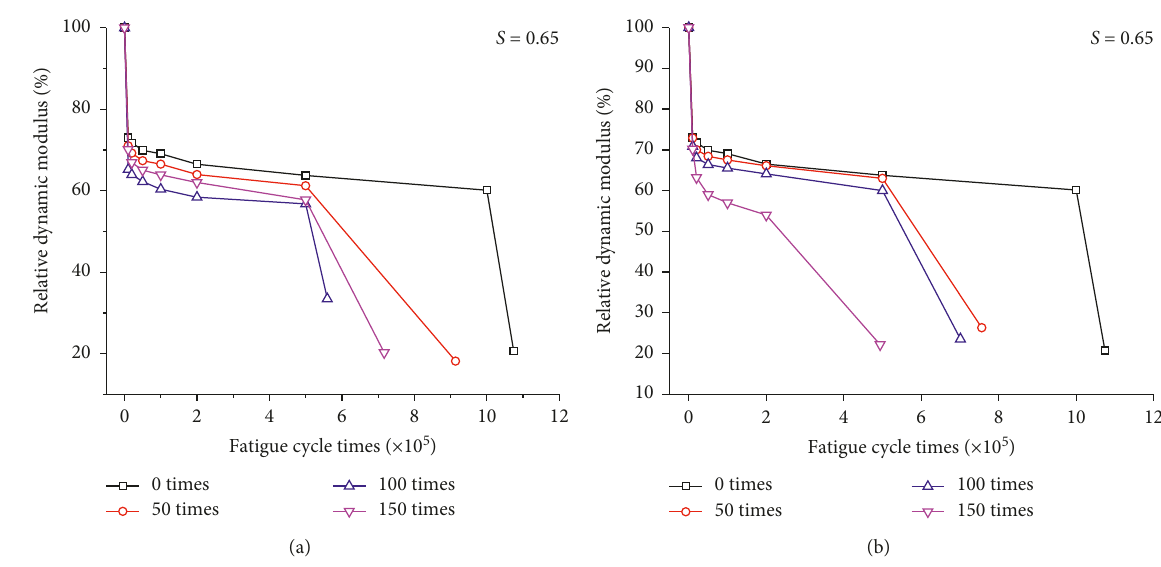
Figure 10: Relative dynamic modulus diagram. (a) Water-frozen specimen. (b) Salt-frozen